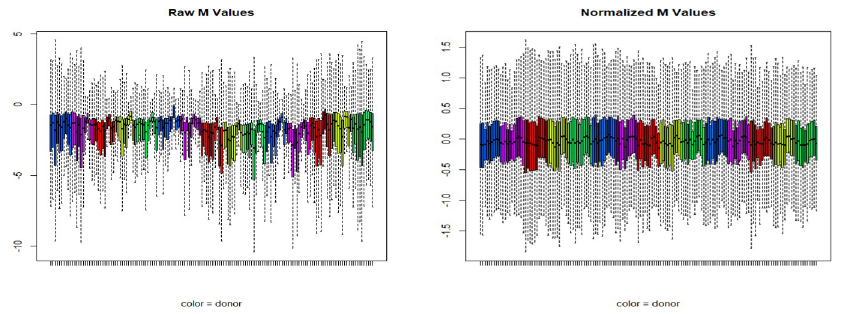
Fig 2. Microarray signal intensity distribution before and after normalization. Raw (a) and normalized (b) microarray probe M values (log2 fold differences) obtained for five different individuals using all different blood collection systems. Colors represent individual